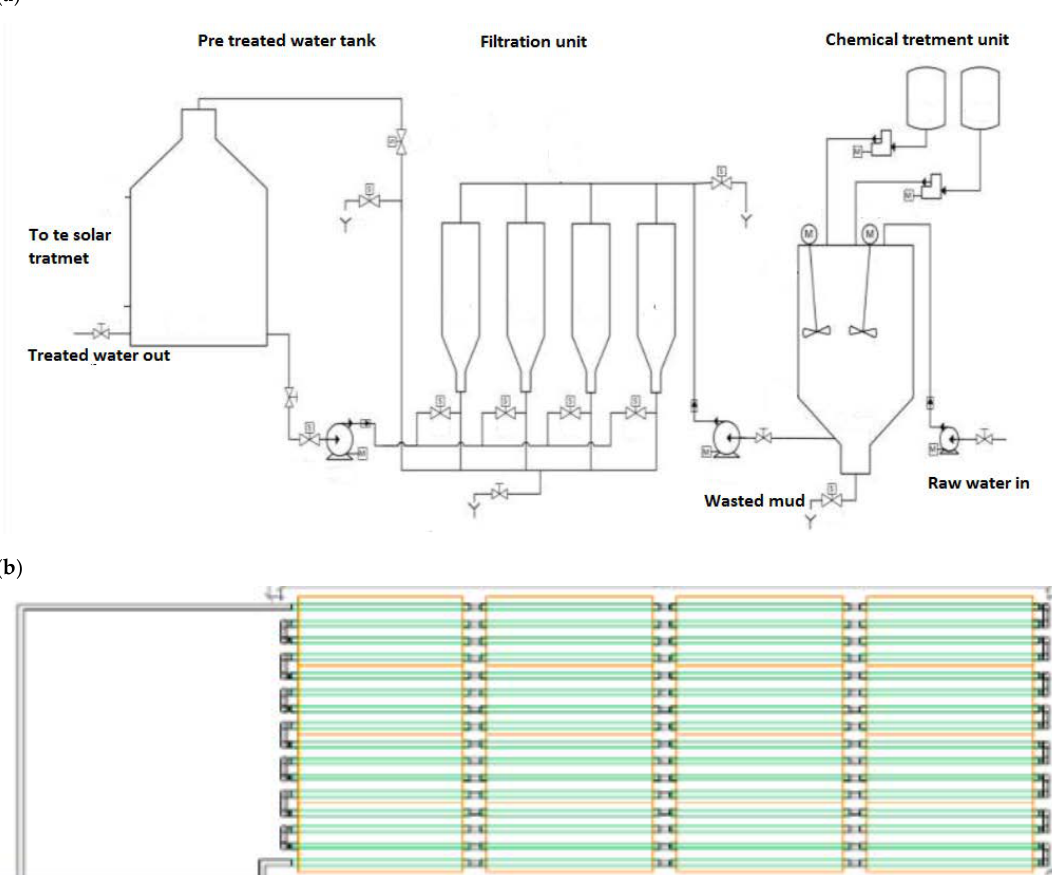
Figure 4. ( a ) Schematic design of the filtration-coagulation water treatment plant. ( b ) Solar compound parabolic concentrator (CPC) reactors to be connected to the filtration unit (proper elaboration). Optimal Performance